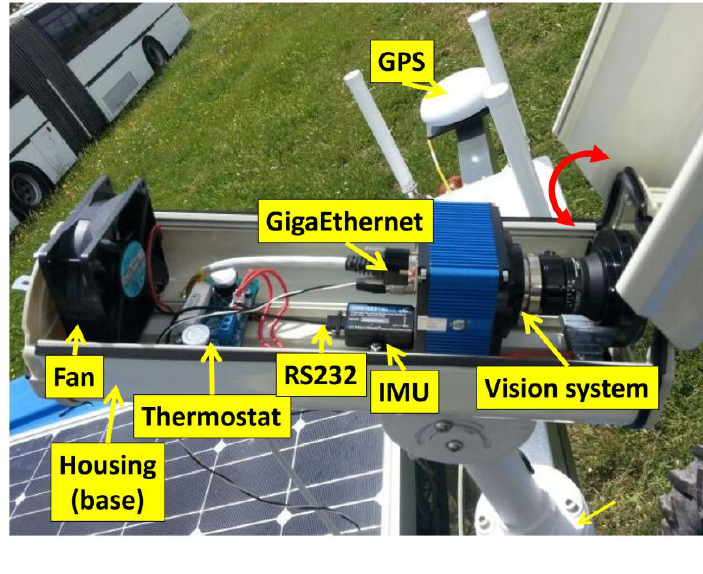
Figure 4. Perception system: sensors and equipment.